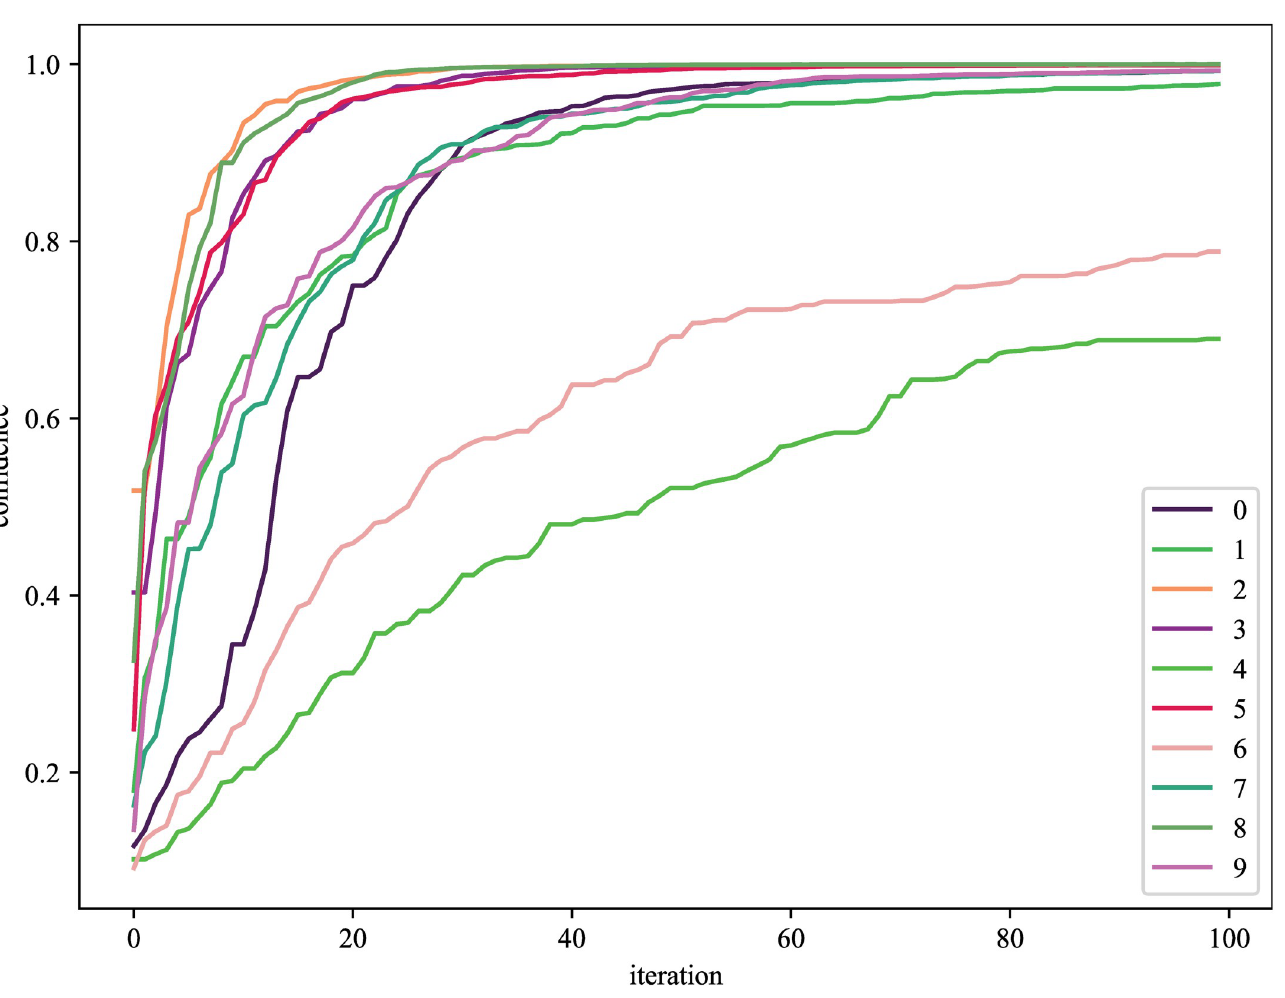
Fig 8. The confidence change of the binary image after